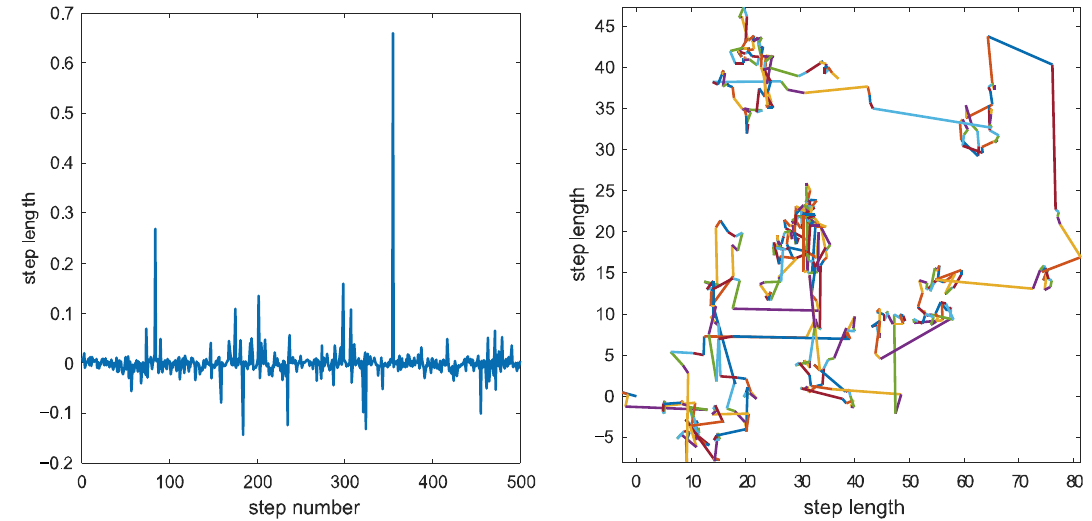
Figure 3. Levy distribution and 2D Levy trajectory.